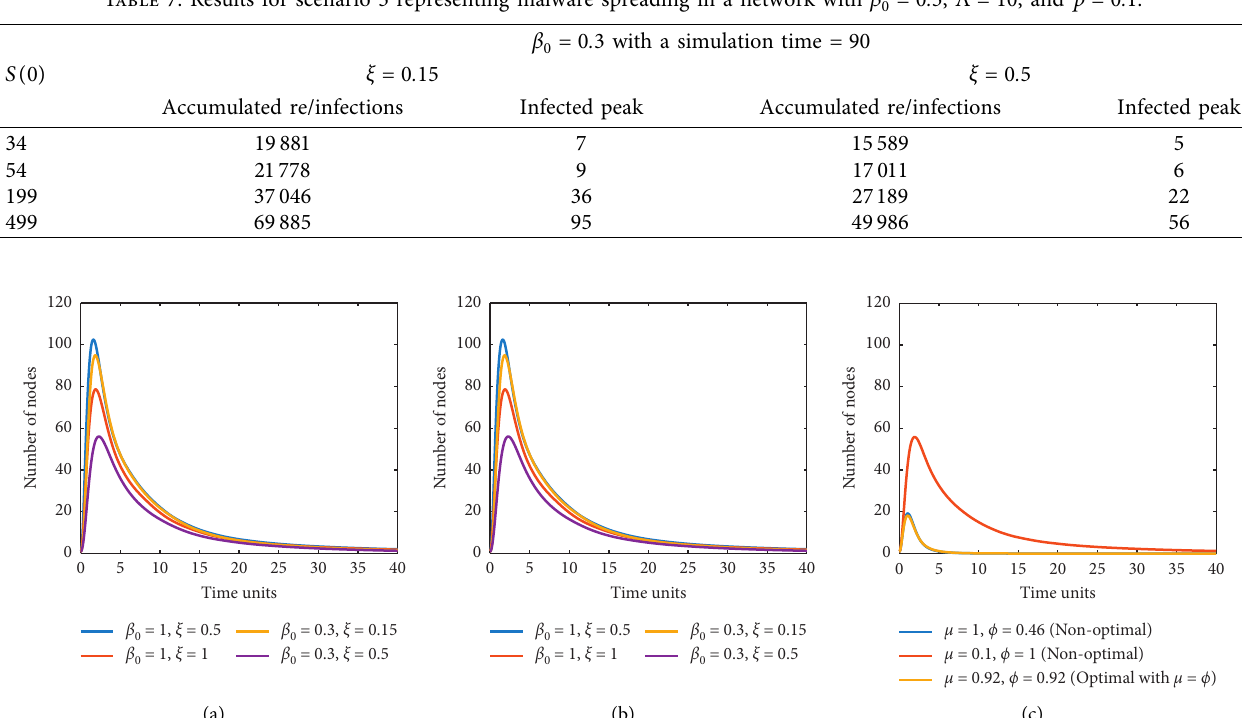
Figure 7: Results for scenarios 2 and 3 with S ( 0 ) � 499. (a) Infected nodes for different combination of parameters β nodes for different combination of parameters β μ and ϕ with Λ � 30 , p � 0 .